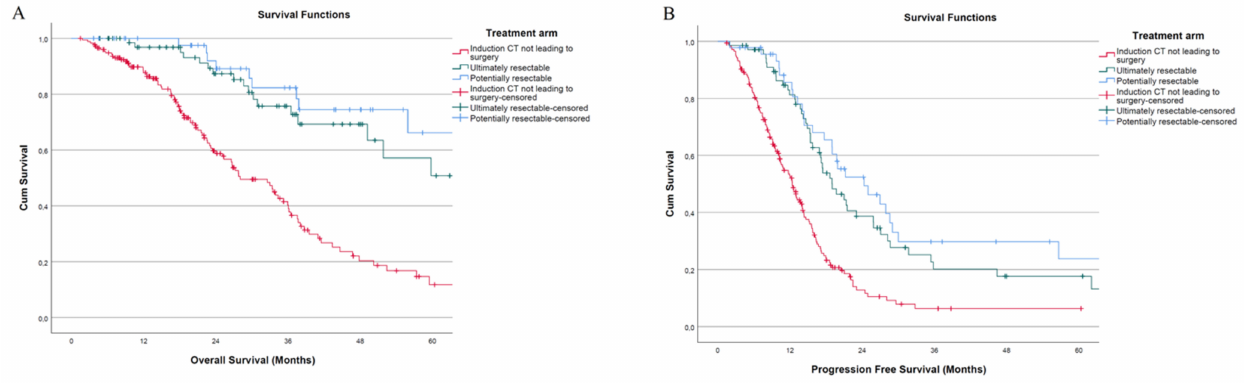
Figure 2. Kaplan–Meier curves of different treatment arms: ( A ) 5-year OS; ( B ) 5-year